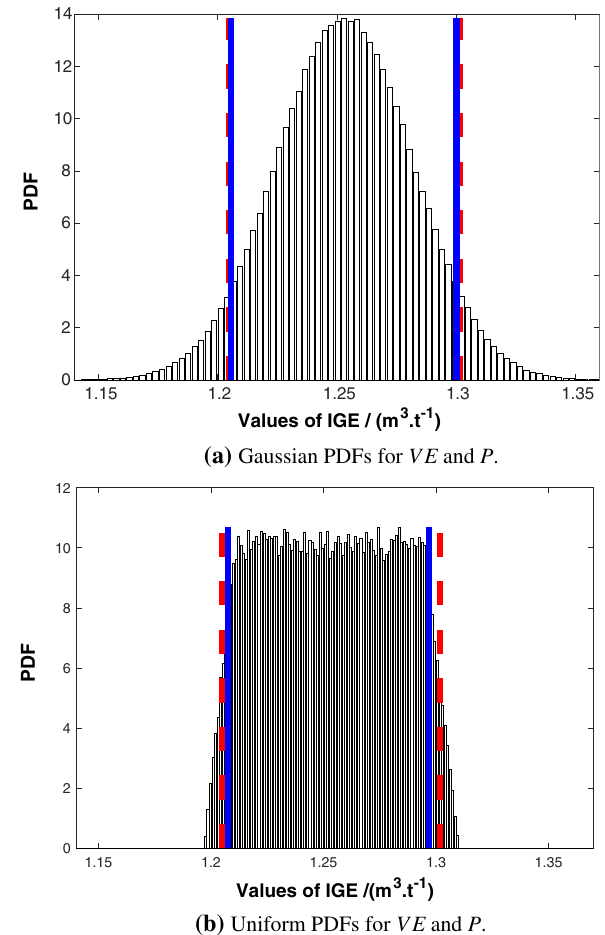
Fig. 3 PDF generated by the GUM S1 method for the measurand IGE. Coverage interval obtained from the GUM method (–), and the GUM S1 method